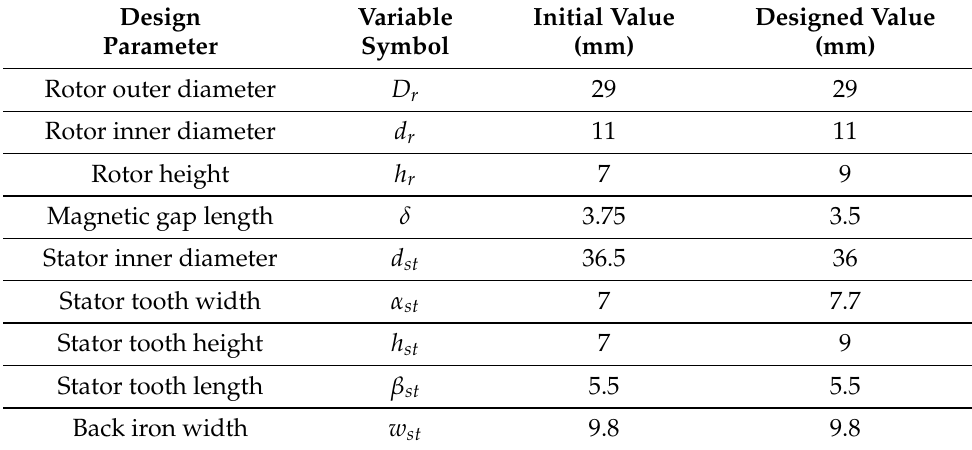
Figure 11. Motor properties under different magnetic gap lengths δ . Table 2. Parameters of